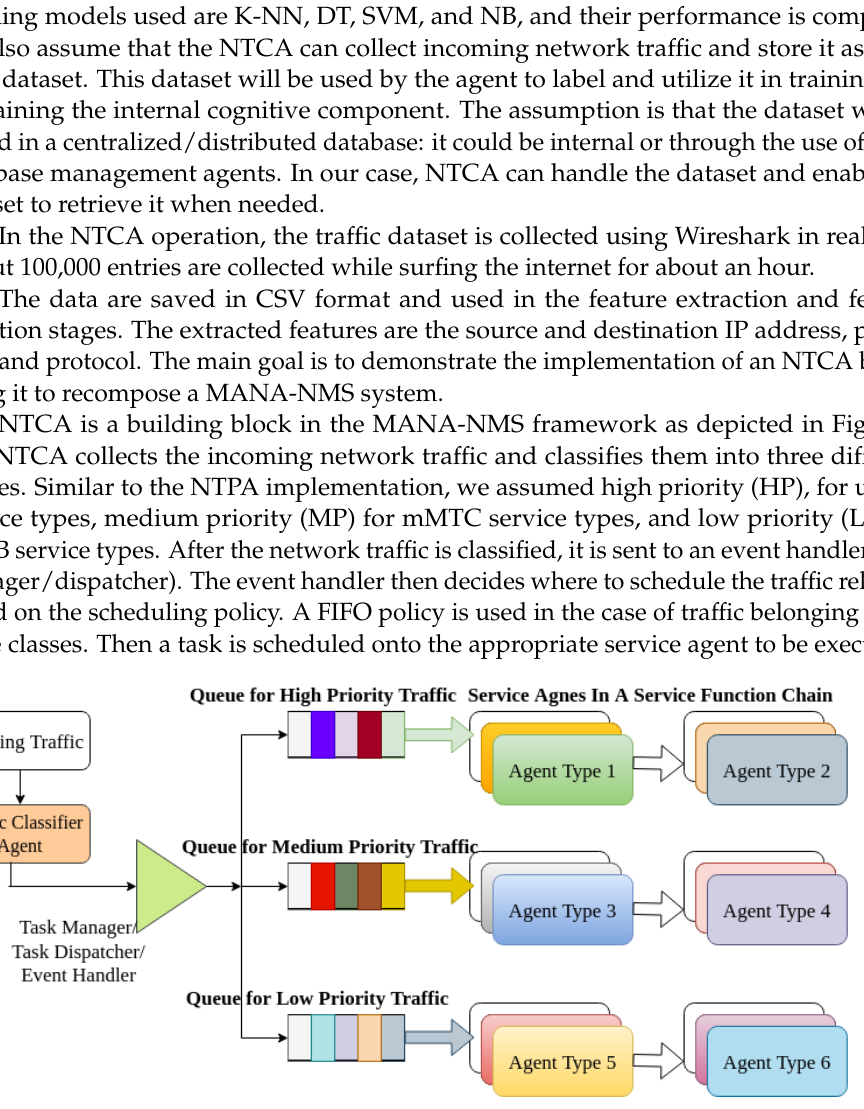
Figure 7. Implemented MANA-NMS